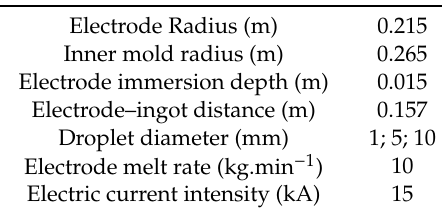
Table 2. Summary of the boundary conditions.